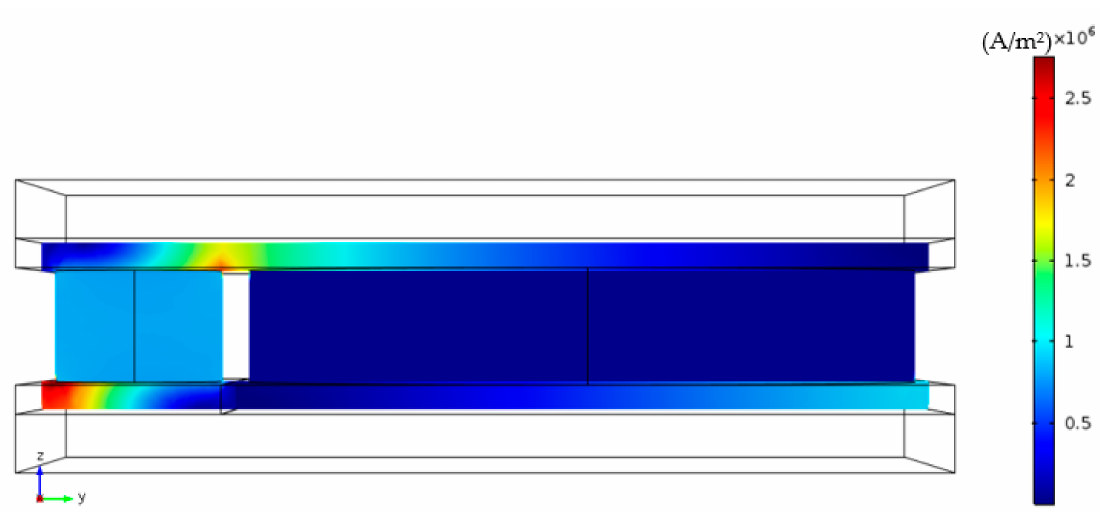
Figure 12. Current density [A/m 2 ] at the mid plane of the TE